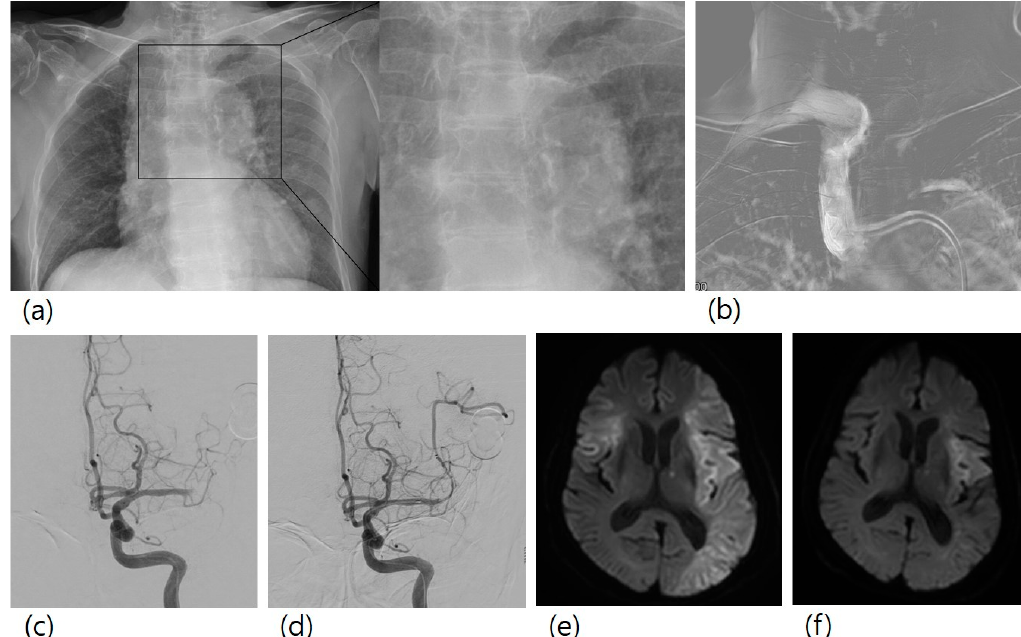
Figure 1. A case of mechanical thrombectomy for left M1 occlusion. A 78-year-old female patient with right hemiparesis visited our hospital. ( a ) Her chest X-ray showed aortic arch calcification. ( b ) In the first step of the procedure, guiding catheter was advanced to the brachiocephalic artery, and a roadmap image was obtained. ( c ) Left M1 occlusion was observed. ( d ) Mechanical thrombectomy with stent retriever was conducted, and successful recanalization was achieved. ( e ) Diffusion-weighted imaging two days after mechanical thrombectomy showed a new lesion in the right MCA territory, ( f ) which was not observed in diffusion-weighted imaging before mechanical throm ‐ bectomy.